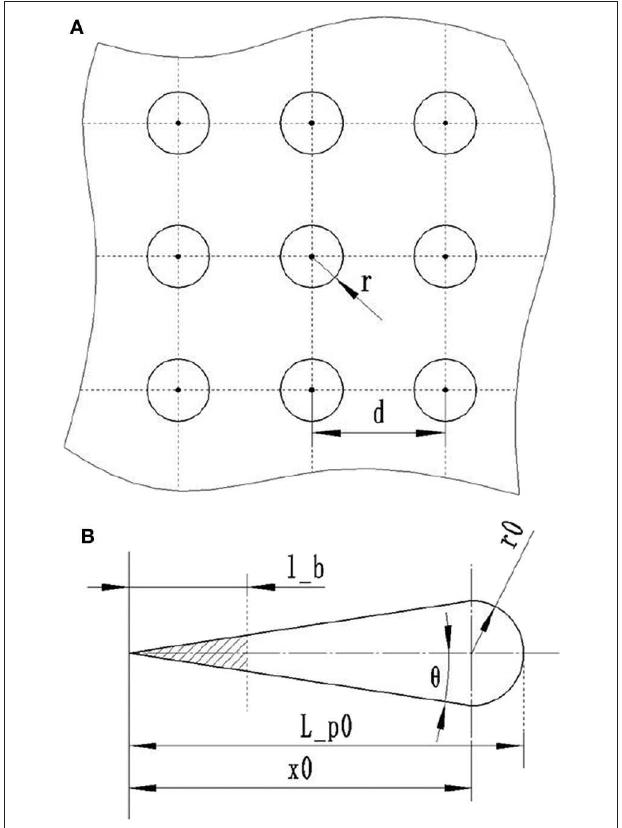
FIGURE 9 | (A) Geometrical assumptions made at initial stage of NG combustion. (B) A 2-D illustration of the approximated diesel spray form at